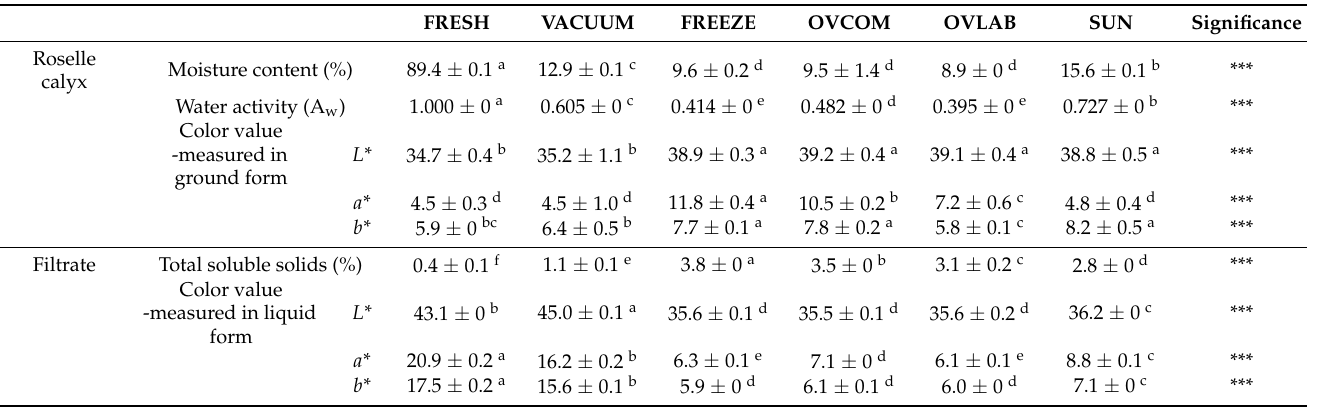
Table 1. Physicochemical properties in the fresh and dried roselle ( Hibiscus sabdariffa L.) calyx and filtrate. FRESH VACUUM FREEZE OVCOM OVLAB SUN